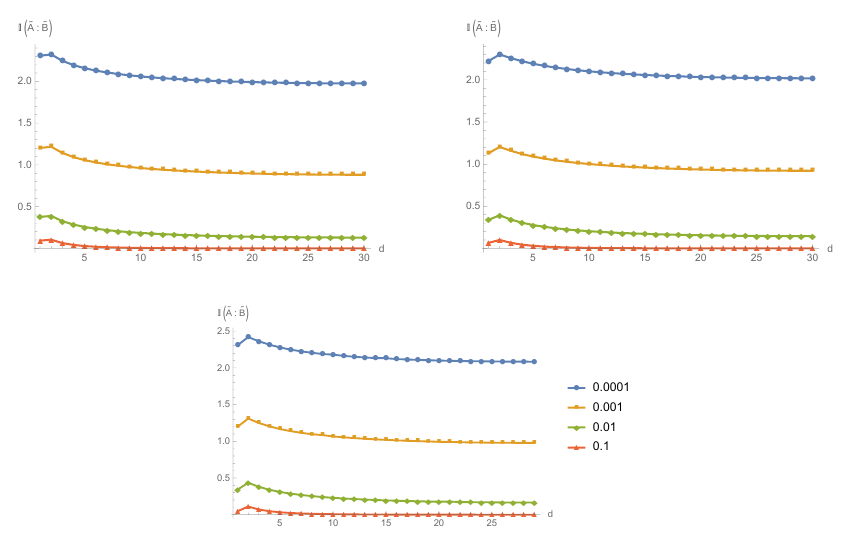
Figure 13 . The left, central and the right one show I ( ~ A : ~ B ) for j A j = j B j = 1 , j A j = 1 ; j B j = 2 and j A j = j B j = 2 respectively, each for m=0.0001,0.001,0.01,0.1 indicated by di(cid:11)erent colors in each of the